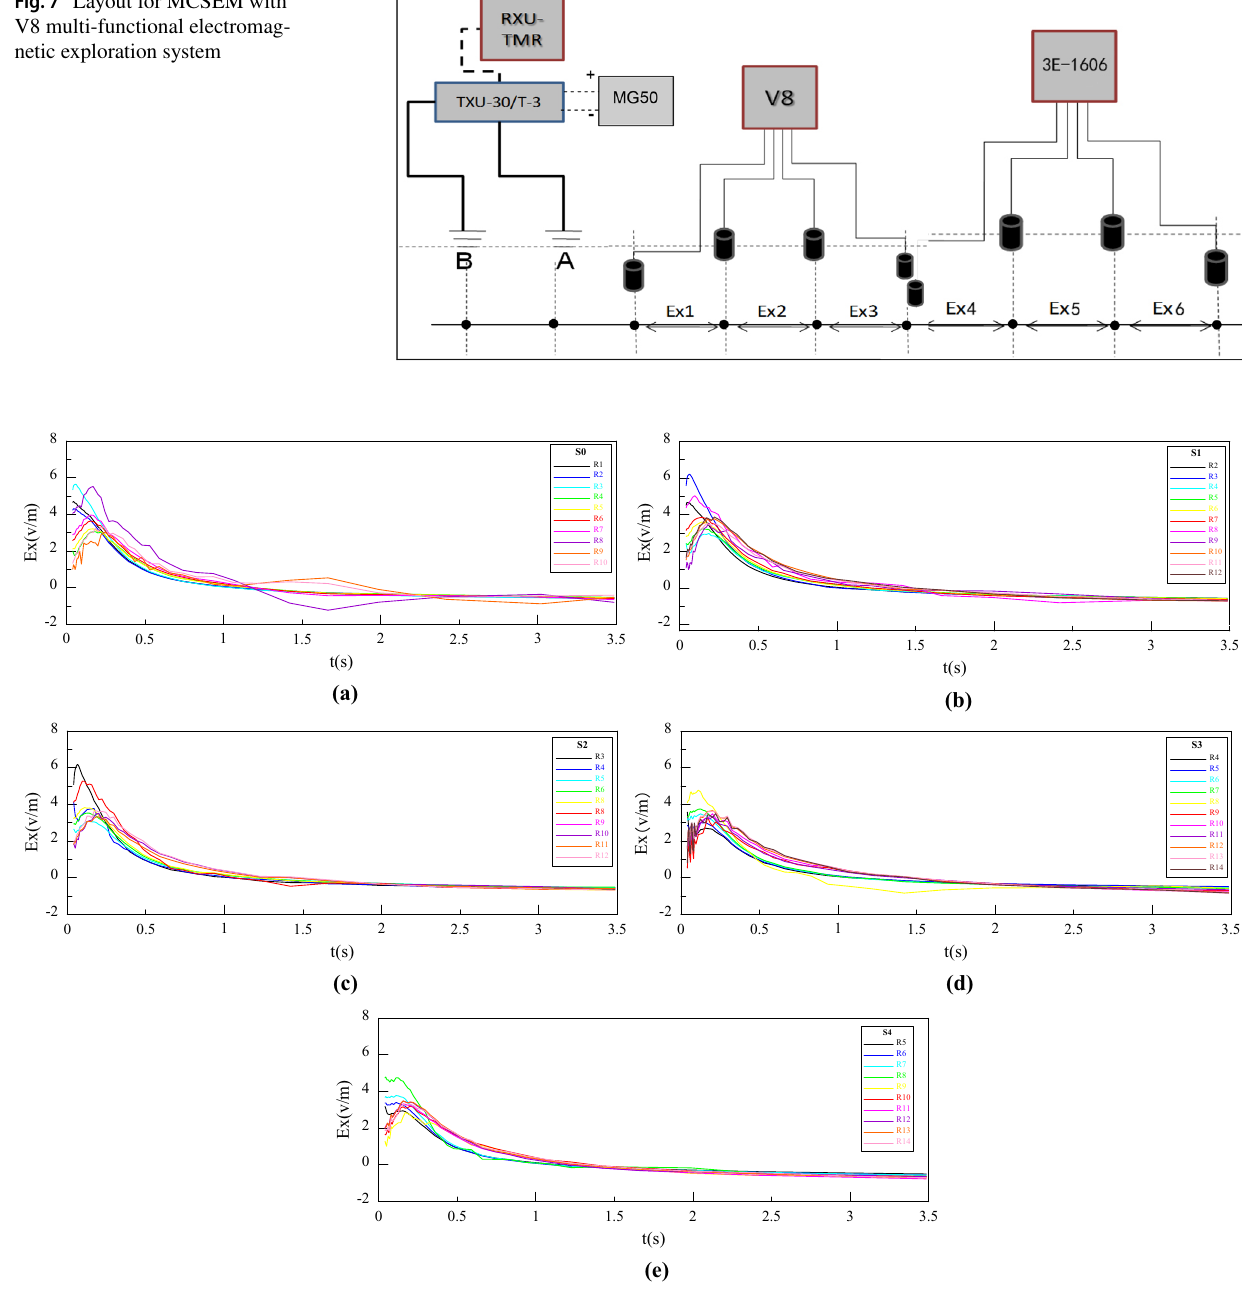
Fig. 8 Impulse response of electric field for the five transmitter sources. a The dipole source is S0 and the receiver array from R1 to R10; b The dipole source is S1 and the receiver array from R2 source was obtained. Using the numerical calculation method to get the peak time corresponding to the response curve of each measuring point, the apparent resistivity was obtained by using Eq. (2). Figure 9 shows the geometry